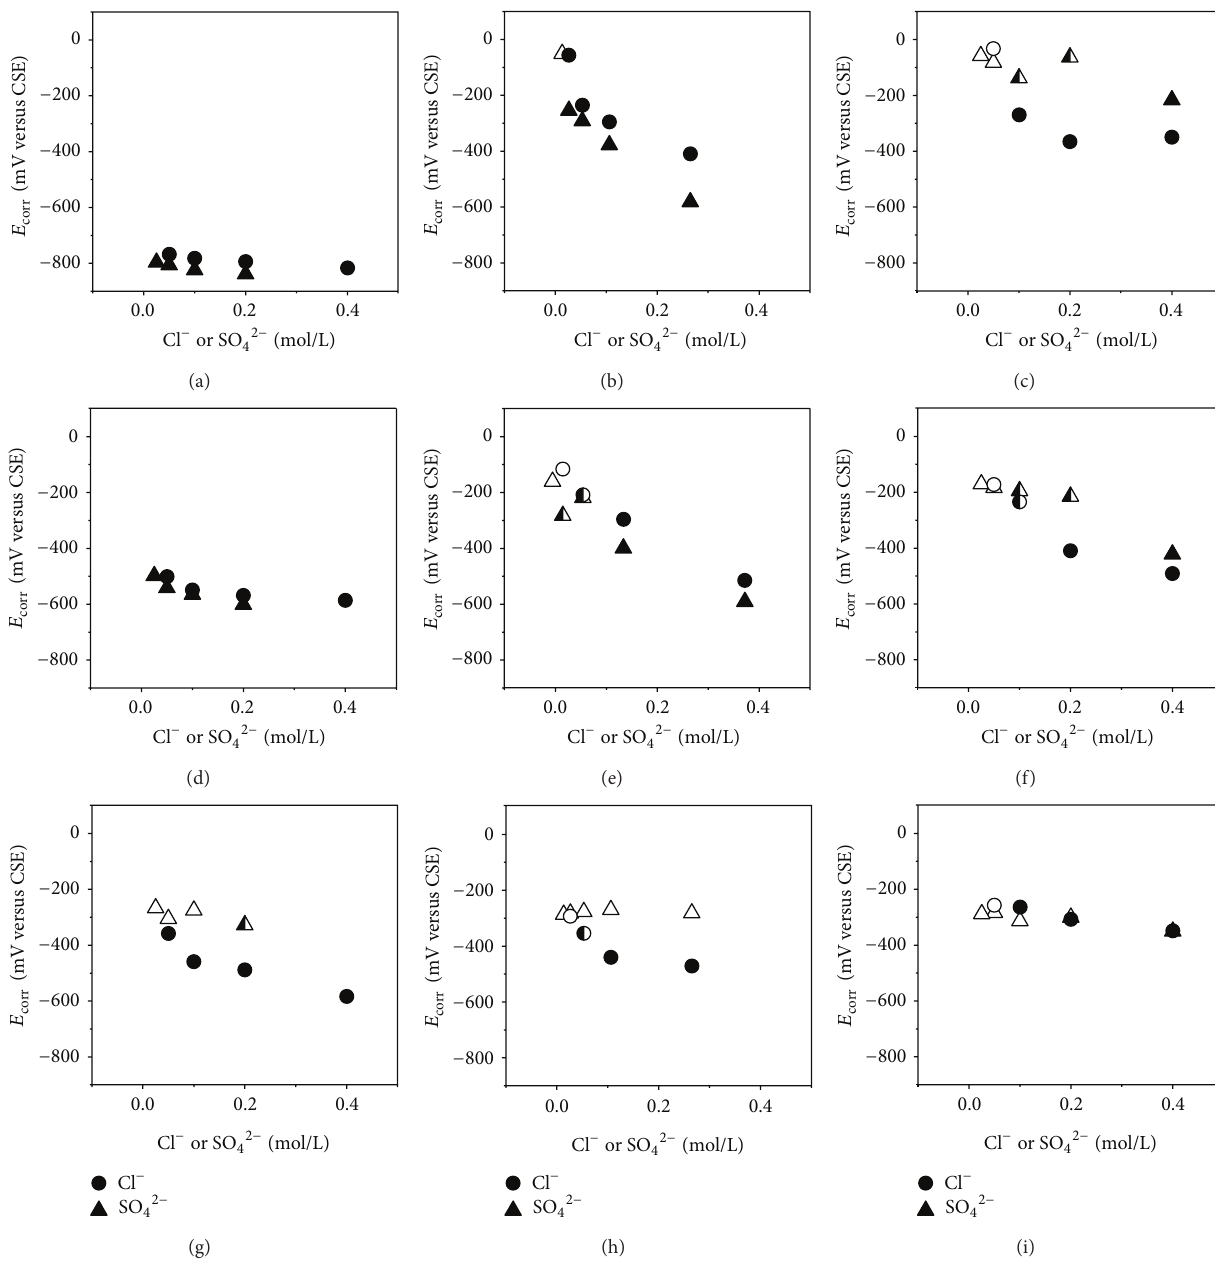
Figure 12: Comparing the 𝐸 induced by Cl − and SO 42− . (a) pH 8.1, NO 2− = 0 mol/L, (b) pH 8.1, NO 2− = 0.053 mol/L, (c) pH 8.1, NO 2− = corr 0.2 mol/L, (d) pH 10.3, NO 2− = 0.0 mol/L, (e) pH 10.3, NO 2− = 0.053 mol/L, (f) pH 10.3, NO 2− = 0.2 mol/L, (g) pH 12.6, NO 2− = 0.0 mol/L, (h) pH 12.6, NO 2− = 0.053 mol/L, (i) pH 12.6, NO 2− = 0.2